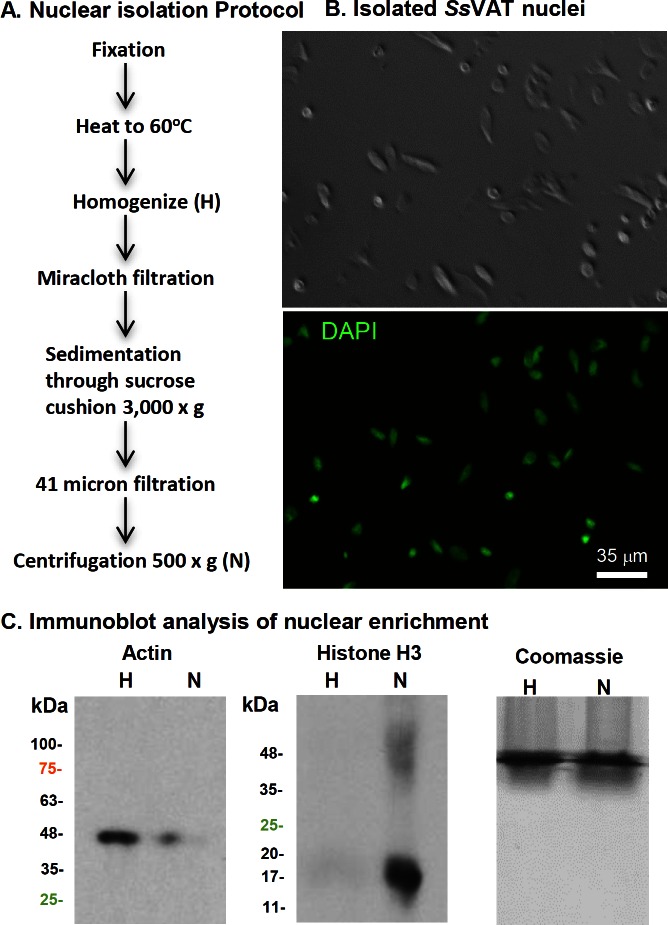
Purifying adipocyte cellular nuclei.A. Protocol for the rapid purification of cellular nuclei from adipose tissue. B. Phase contrast microscopic image (upper panel) and fluorescent microscopic image of DAPI staining (lower panel) of total VAT nuclei. DAPI stained for DNA (green). Phase contrast image of nuclei showed there was very little cellular debris. C. Western blot comparing the levels of actin and histone H3 in total SsVAT homogenate (H) and purified ssVAT nuclear protein extracts (N).